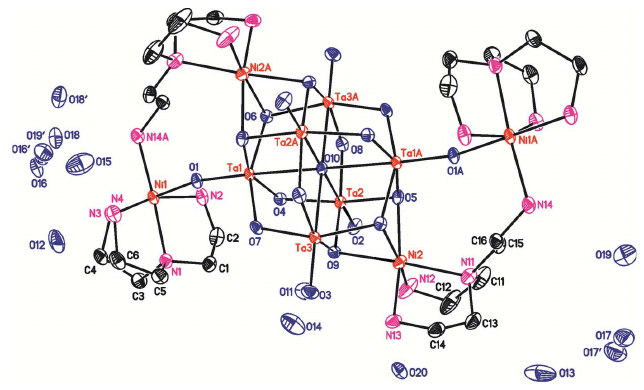
Figure 1 The molecular entities in the crystal structure of the title compound with